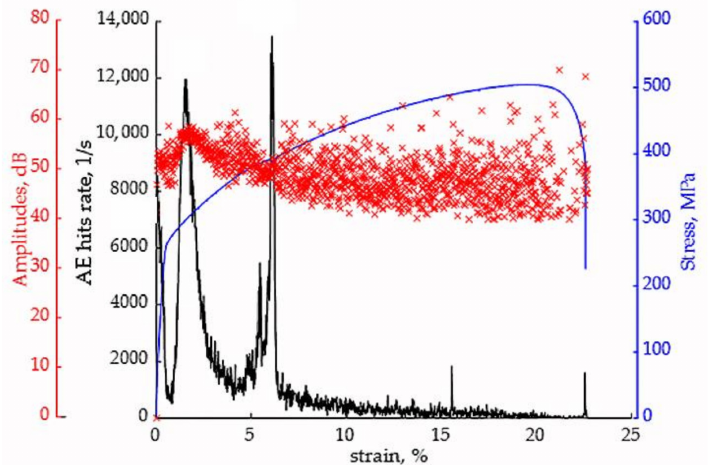
Figure 8. AE data recorded under tension of a specimen of a dissimilar welded joint with diffusion interlayers. All three data arrays (stress—blue, AE hits rate—black, and AE amplitude—red) depend on the same argument (strain,